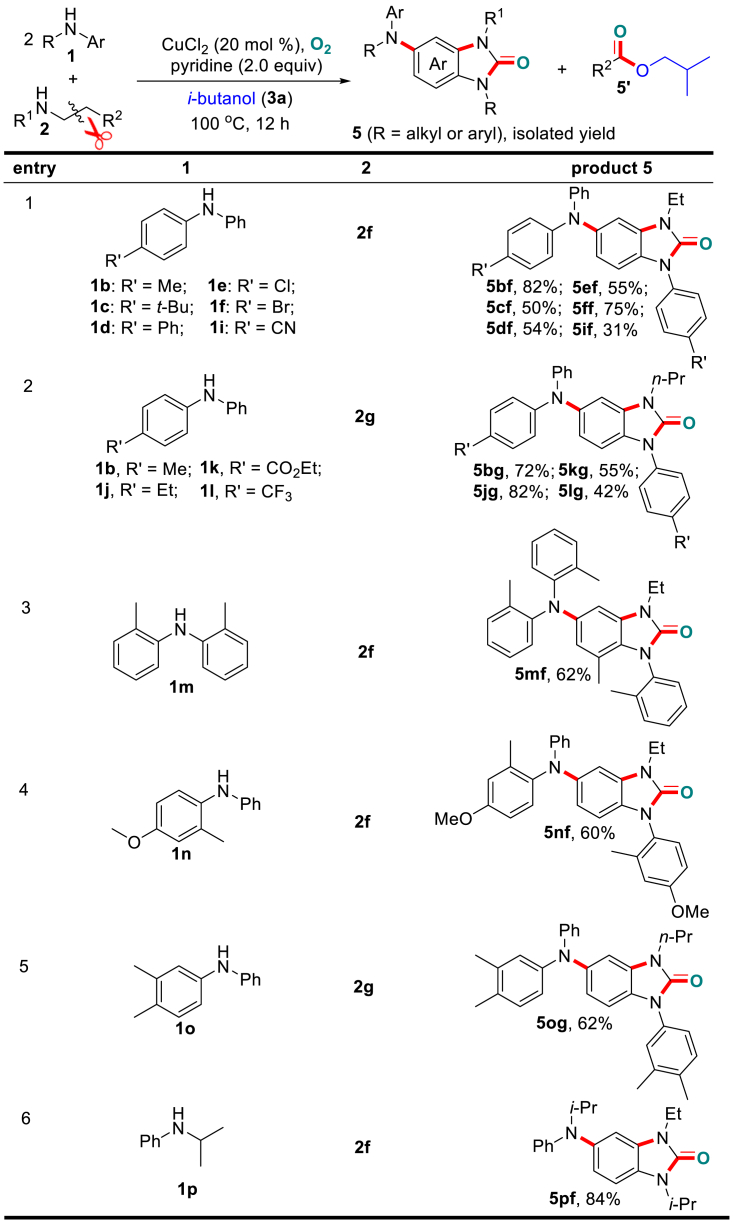
Variation of Both Dialkyl- and ArylaminesStandard condition deviation: without addition of Na2CO3. Also see Figures S52–S83.